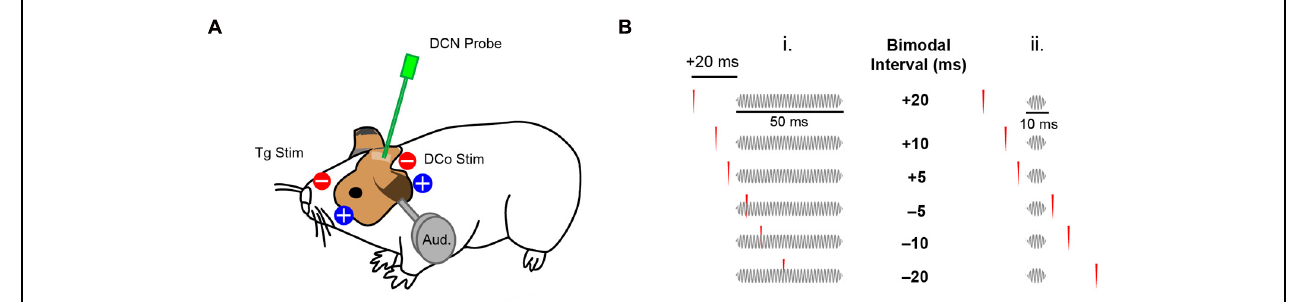
FIGURE 1 | Transcutaneous electrical stimulation and bimodal pairing protocol. (A) Skin electrode pads were placed on the ipsilateral face and neck to activate the trigeminal (Tg) and dorsal column (DCo) somatosensory pathways. DCN neural responses were recorded during electrical and auditory